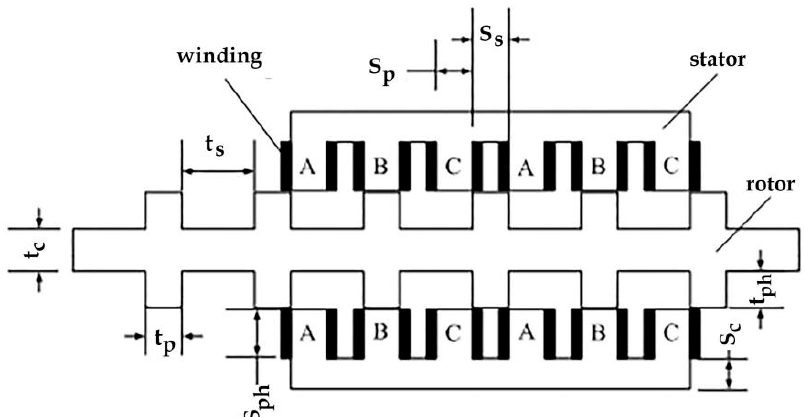
Figure 1. Basic structure of Double-sided Linear Switched Reluctance Generator (DLSRG). The motor consists of the stator, the rotor, the motor housing, the windings, the slot wedges, the linear bearing.